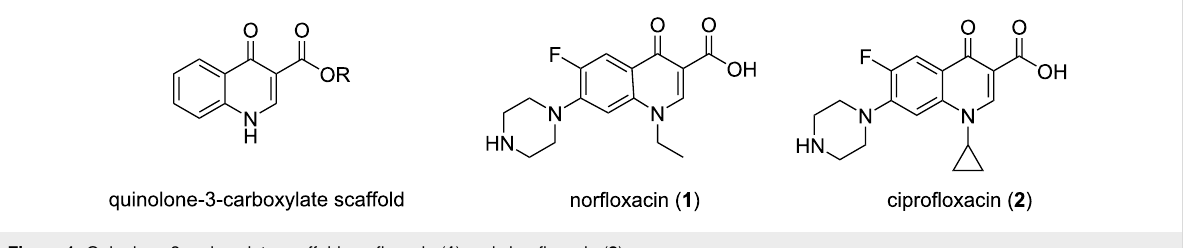
Figure 1: Quinolone 3-carboxylate scaffold, norfloxacin ( 1 ) and ciprofloxacin ( 2 ).